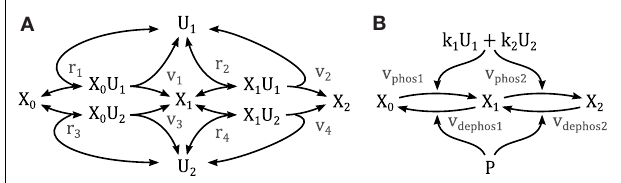
FIGURE 9 | Schemes of a double phosphorylation cycle with two kinases. X denotes the protein to be phosphorylated with the index indicating its phosphorylation status. U denote the kinases catalyzing the phosphorylations. (A) Full mechanistic scheme modeled using mass action kinetics. For clarity of presentation, the dephosphorylation reactions are not depicted. (B) Reduced scheme modeled using Michaleis-Menten type kinetics as derived in the main text; k 1 and k 2 denote the catalytic activity of U 1 and U 2 , respectively. P denotes the phosphatase catalyzing the dephosphorylation.